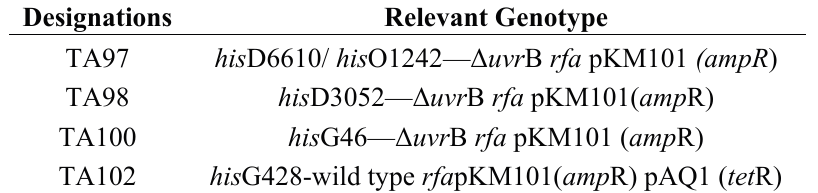
Table 5. Strains of Salmonella typhimurium used in the reverse mutagenesis to histidine prototrophy (Ames test)—“Spot test”.